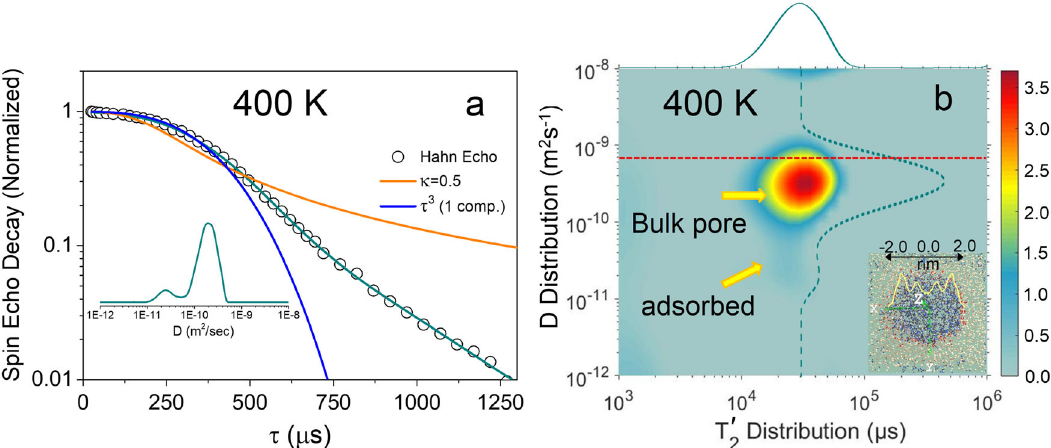
Fig. 4 2D 1 H NMR diffusion-relaxation ( D − T 0 ) spectrum at 400 K. a The 1 H NMR Hahn SED of [BMIM] + [TCM] − con fi ned in MCM-41 at 400 K. The 2 green line is the fi t, and the inset the relevant self-diffusion coef fi cient D distribution, acquired by using a Tikhonof regularization inversion algorithm 34,35 . The blue and orange color lines are the single exponential τ 3 decay according to Eq. (1) and SFD, according to Eq. (2) with κ = 0.5, respectively. b The 1 H NMR D − T 0 spectrum at 400 K. At elevated temperatures adsorbed [BMIM] + [TCM] − molecules at the MCM-41 pore walls become more mobile; a 2 distribution of D values is observed, with the slower D -component belonging to molecules very close to the pore walls. The red dotted line declares the D value of the bulk RTIL at 400 K. The inset is snapshot of a molecular dynamics simulation at 400 K. The yellow line is the radial RTIL density distribution.